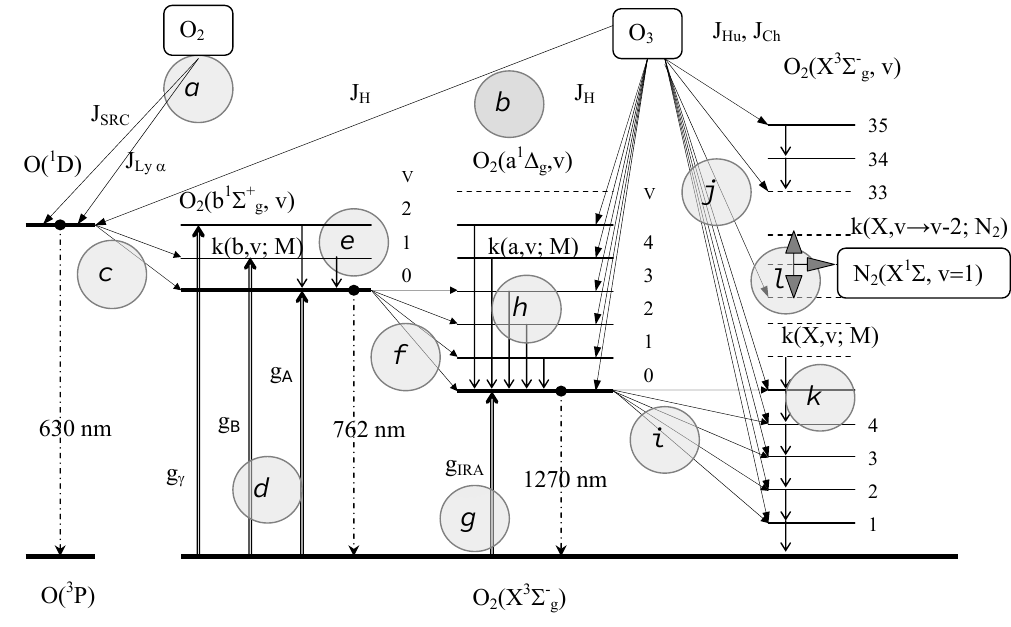
Fig. 1. The scheme of electronic-vibrational kinetics of the products of O 3 and O 2 photolysis in the middle atmosphere. Table 1. Processes of O 2 and O 3 photodissociation and photoexcitation. Short notations for electronically excited states of oxygen